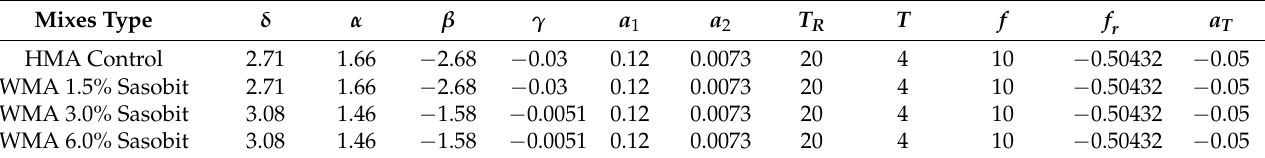
Table 8. Master curve parameters.